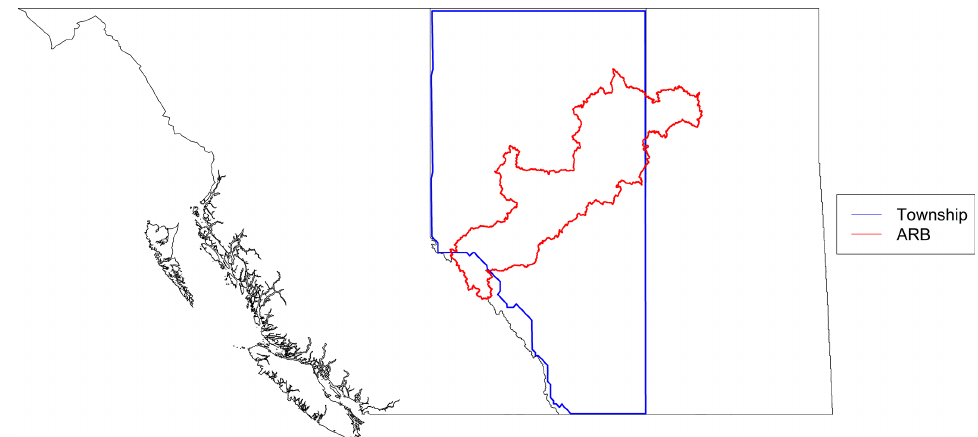
Figure 8. Domain of the Township dataset (blue line) and the boundary of the Athabasca River basin (red line).